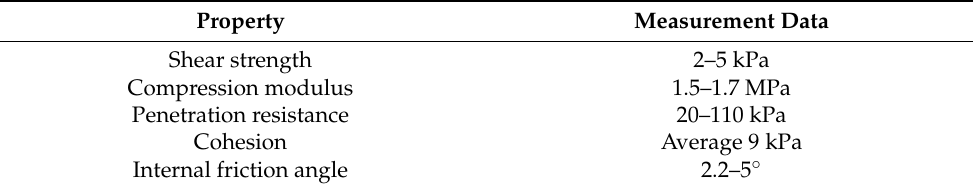
Table 5. Main mechanical properties of soil.